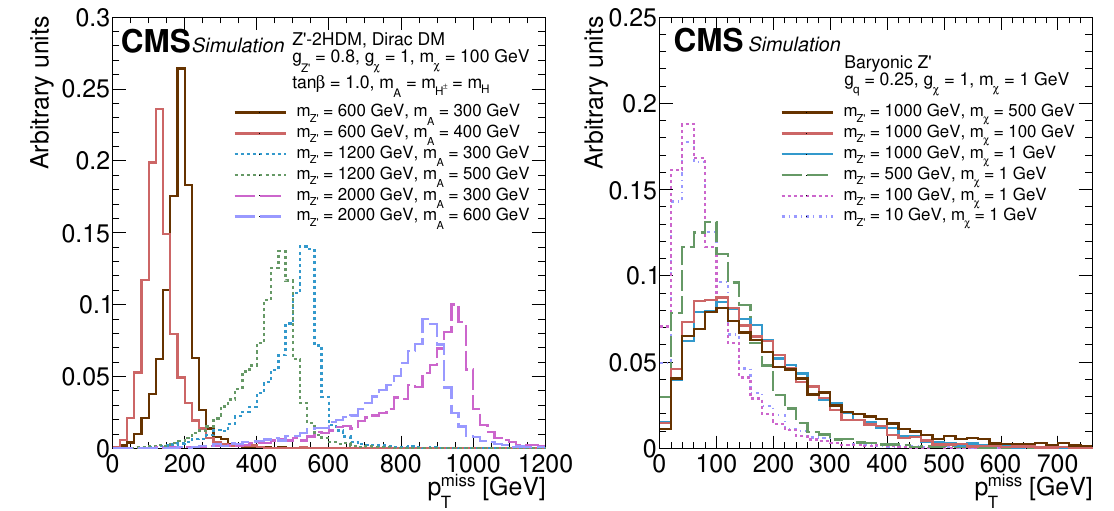
Figure 2 . The distribution of p miss dependence on the two main model parameters varied in the analysis, m baryonic Z 0 model (right), showing the variation of p miss rameters of the models are (cid:12)xed to the values speci(cid:12)ed in the text. The distributions are normalized to unit